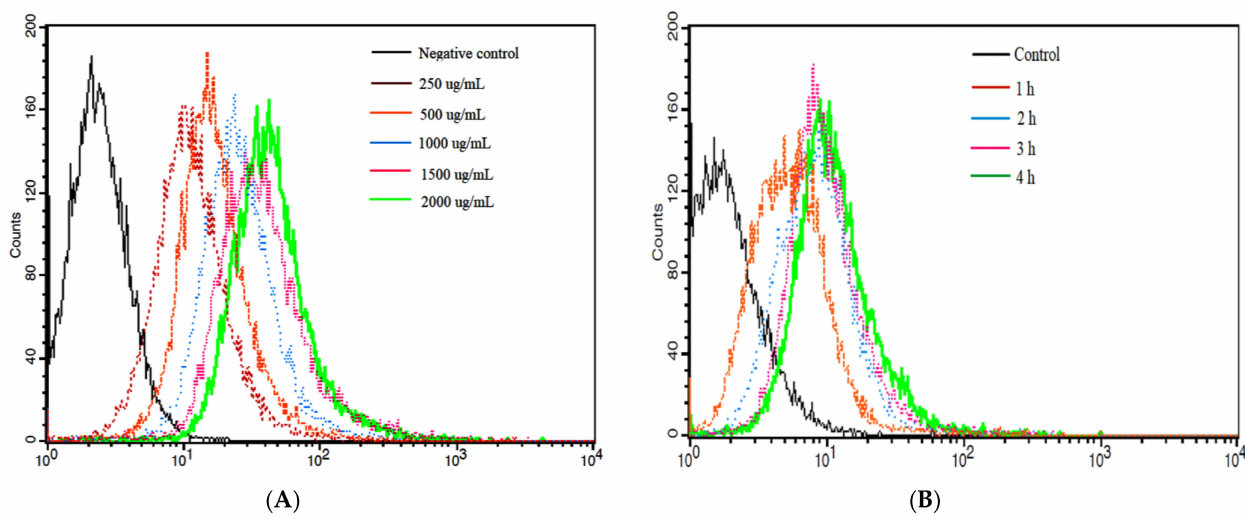
Figure 6. The internalized NPPc in Caco-2 cells via flow cytometry method (FCM). Effects of a series of incubation concentrations on the uptake of NPPc for 4 h ( A ), and effects of a serious of incubation time points on the uptake of NPPc at a concentration of 500 µ g/mL ( B